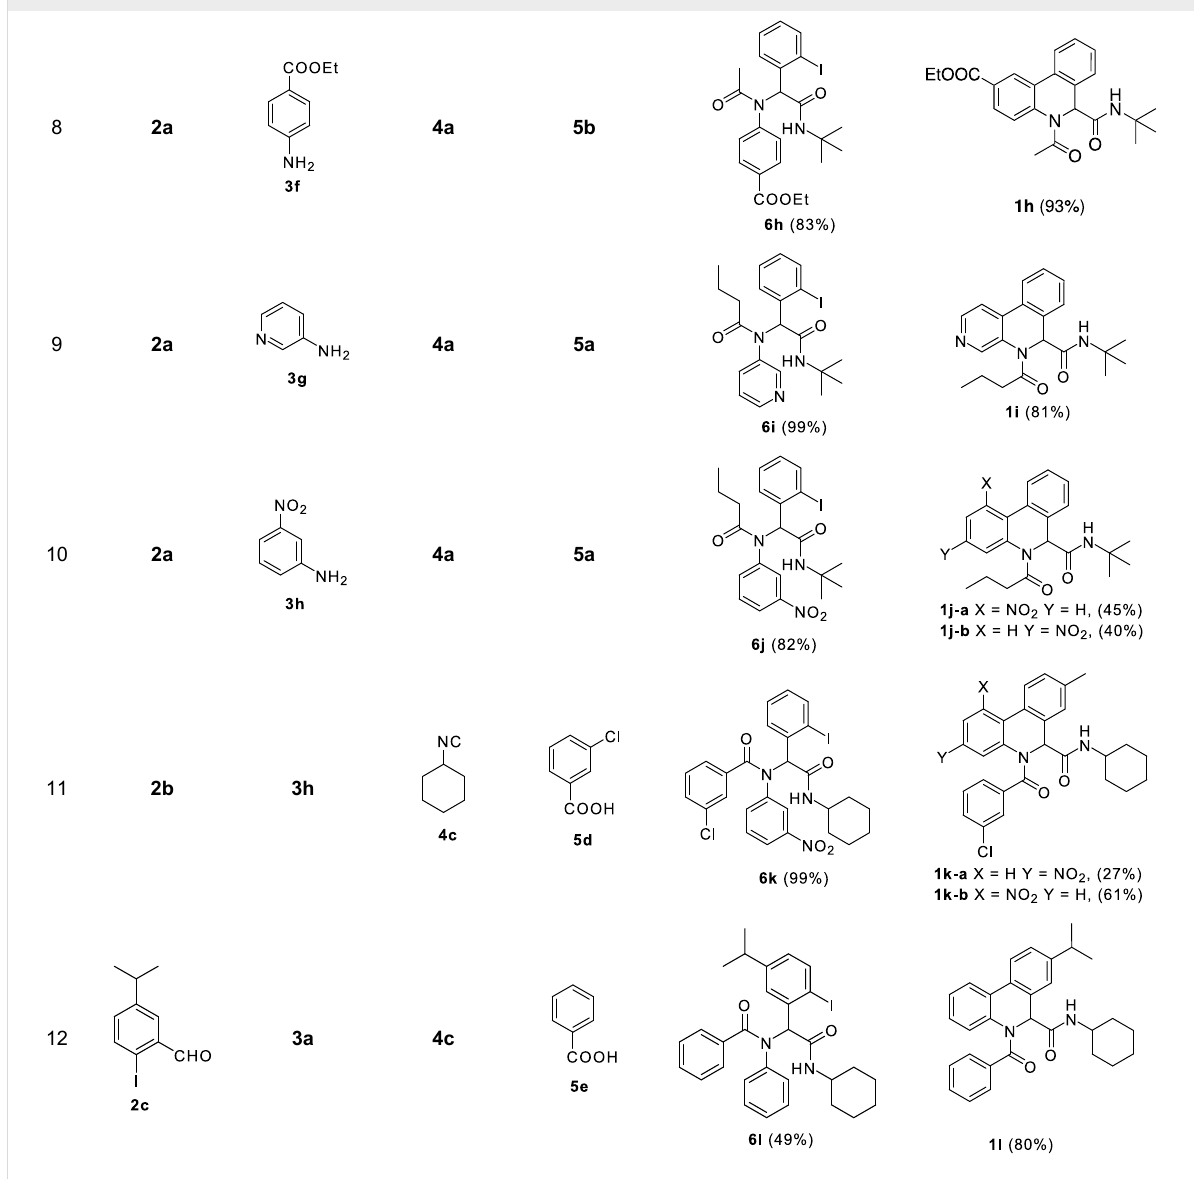
Table 2: Two step synthesis of dihydrophenanthridines 1 .